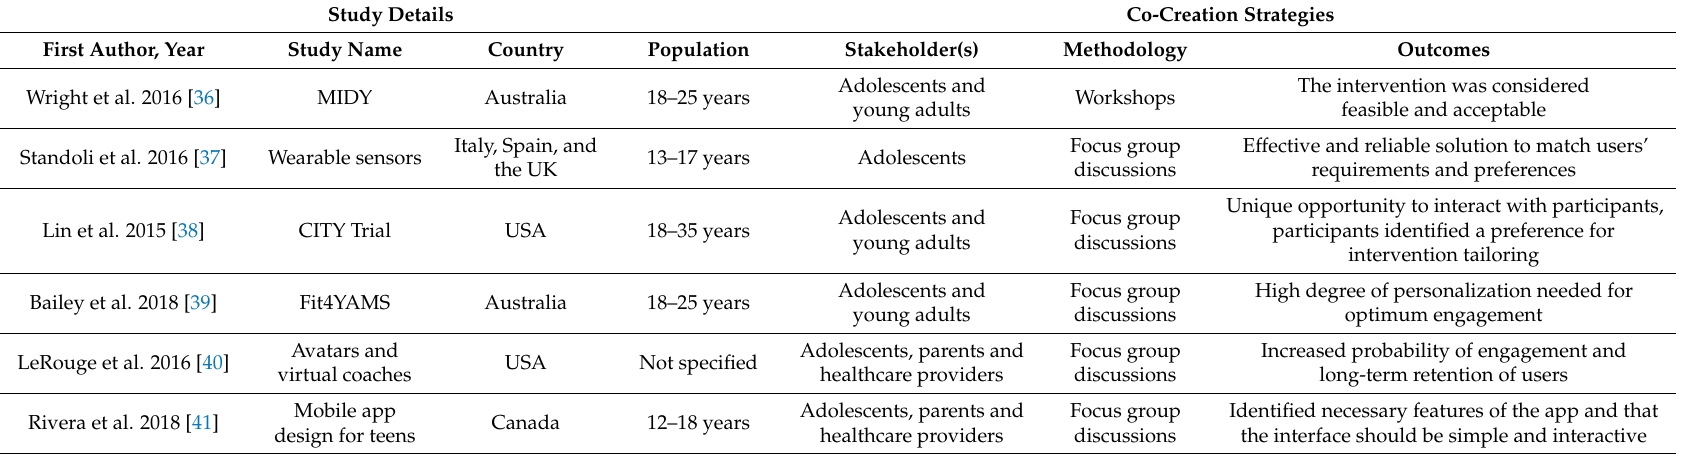
Table 1. Summary of eHealth lifestyle interventions targeting one or more CVD risk factors that have been co-created with